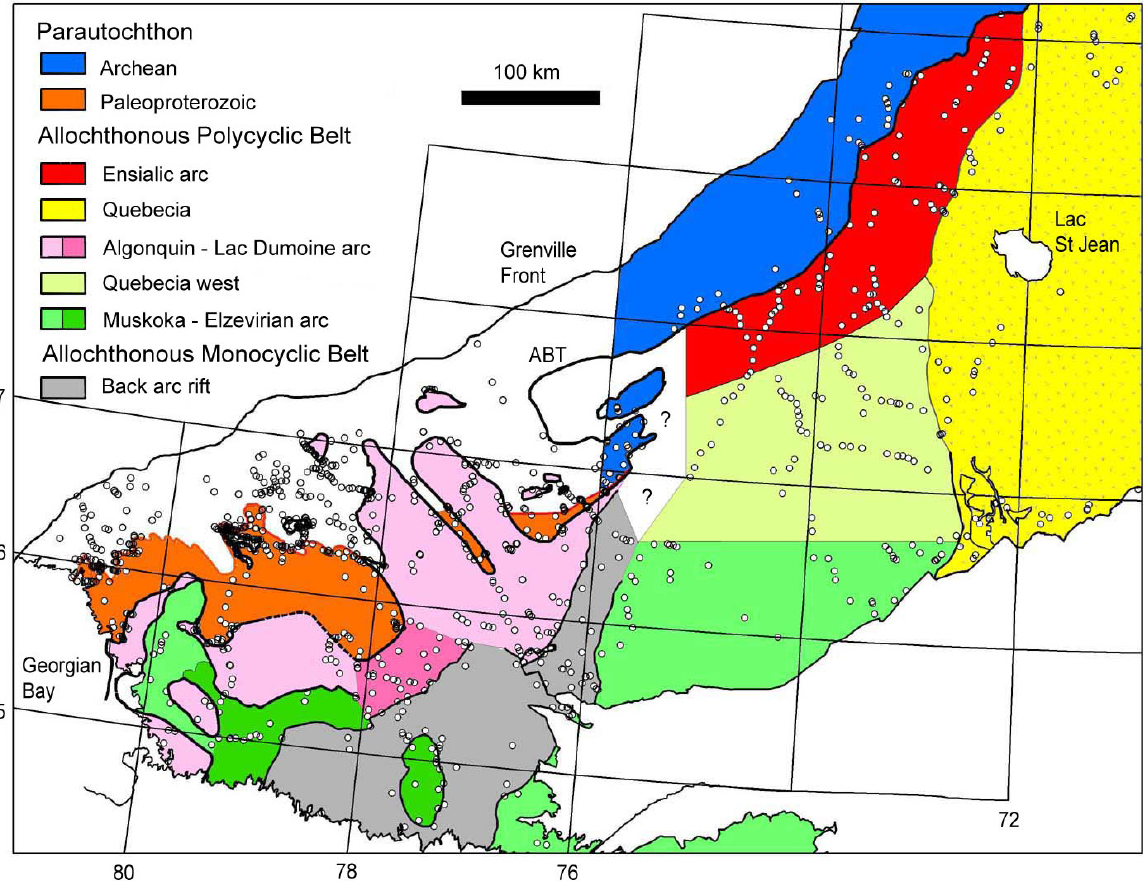
Figure 7. Map of the western Grenville Province showing the change in the age of the Mesoproterozoic Laurentian margin from Archean (blue) in the central Grenville Province to Palaeoproterozoic (orange) in the SW. Red = ensialic arc established on Archean margin (present study area); pink = ensialic arc established on Palaeoproterozoic crust (dark pink = data that generated the Algonquin mixing lines in Figures 4 and 5); pale green = ensialic arc established on the accreted Mesoproterozoic margin; darker green = ensialic arc established on the older Mesoproterozoic ensialic